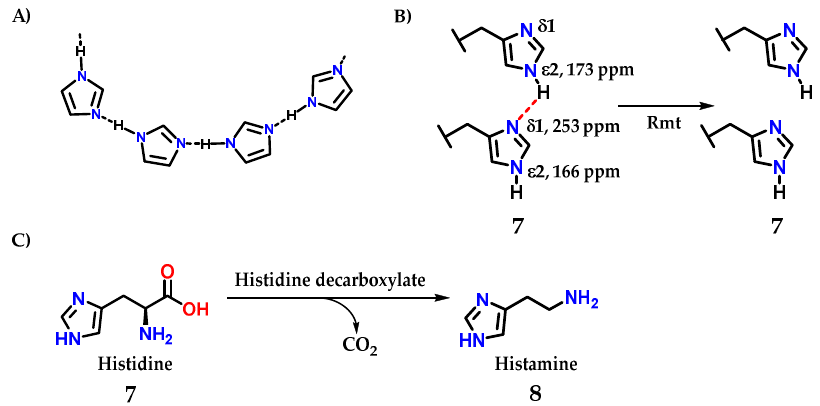
Figure 5. ( A ) Intermolecular interactions through the hydrogen interactions that imidazole- containing derivatives can perform. ( B ) Intermolecular interactions through the hydrogen interactions in histidine residues. ( C ) Structure of histidine 7 , precursor of histamine 8 biosynthesis.